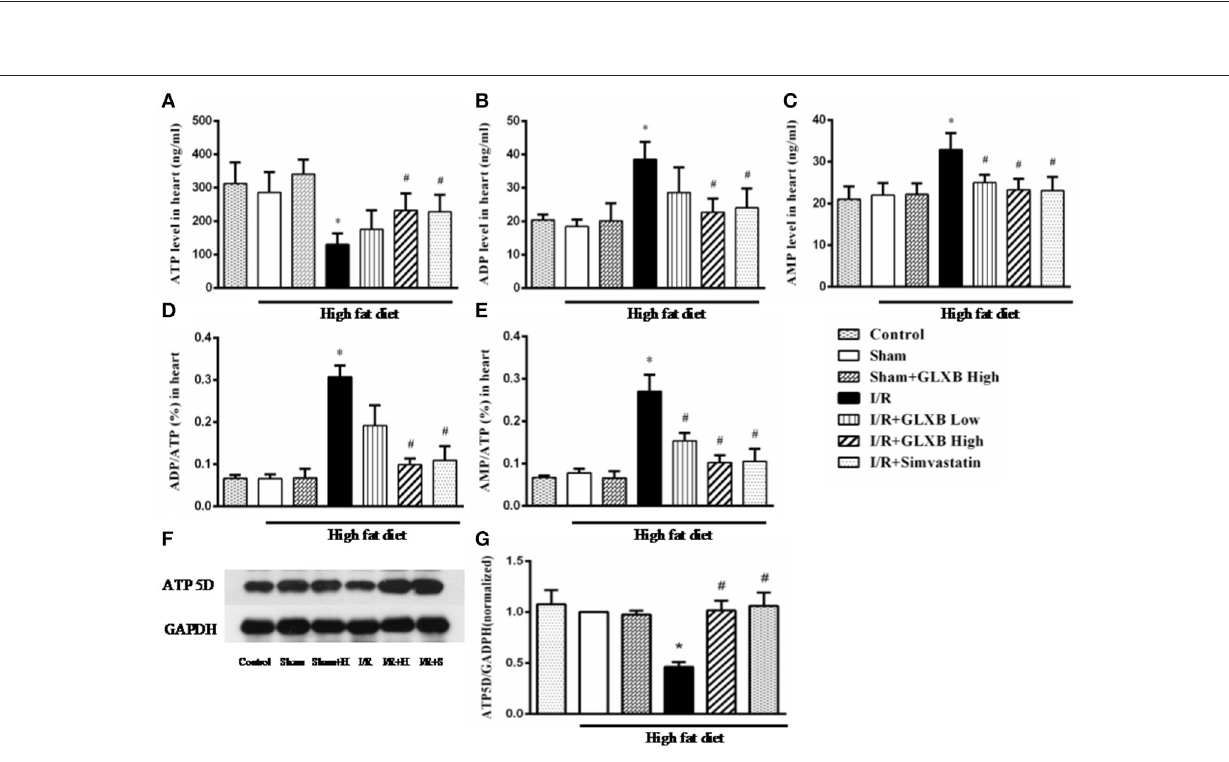
Frontiers in Physiology |